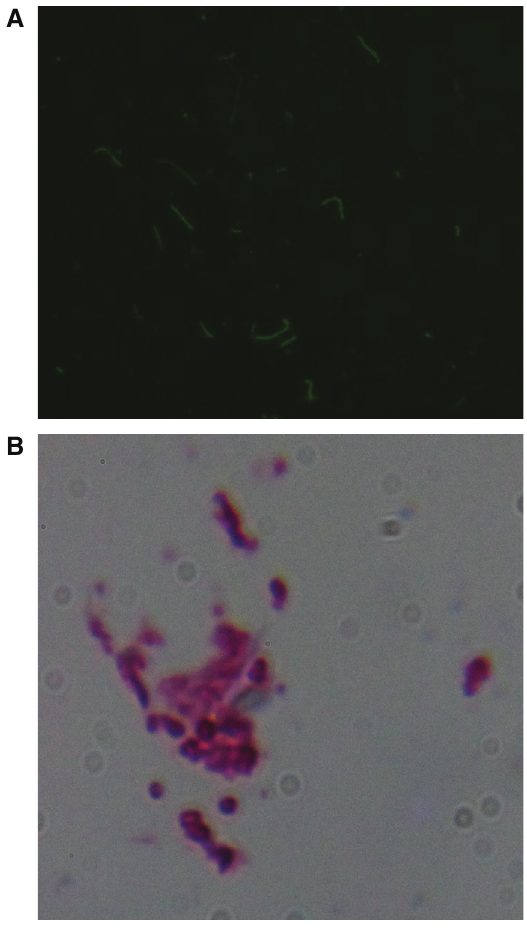
Figure 2. A : B. burgdorferi immunostaining of vaginal culture from Patient 1. Note intensely staining spiral and round forms in culture. 400× magnification. B : B. burgdorferi immunostaining of seminal culture from Patient 6. Note intensely staining spiral and round forms in culture. 400× magnification. See Dataset, data file 3.